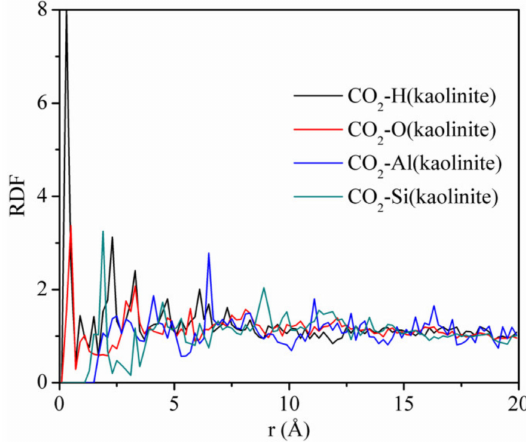
Figure 12. RDFs between CO 2 and di ff erent atoms of kaolinite at the pressure of 5 MPa and the temperature of 293.15